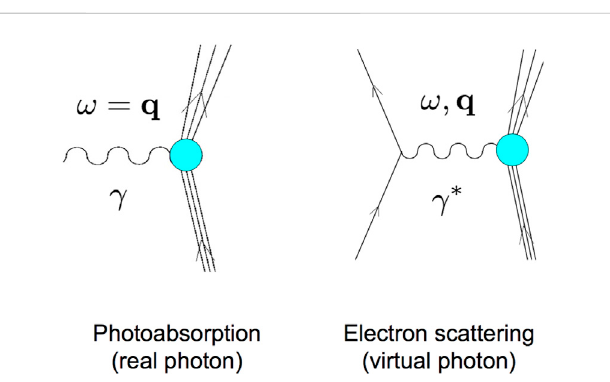
FIGURE 1 The χ EFT expansion of the nuclear Hamiltonian and electromagnetic currents. The fi lled circles, squares and diamond denote strong-interaction vertices with chiral dimension 0,1 and 2, respectively.The ⊗ symbolsdenotetheelectromagneticvertices.In the literature, ] 0 is usually taken as 0 for the potential and − 3 for the currents.